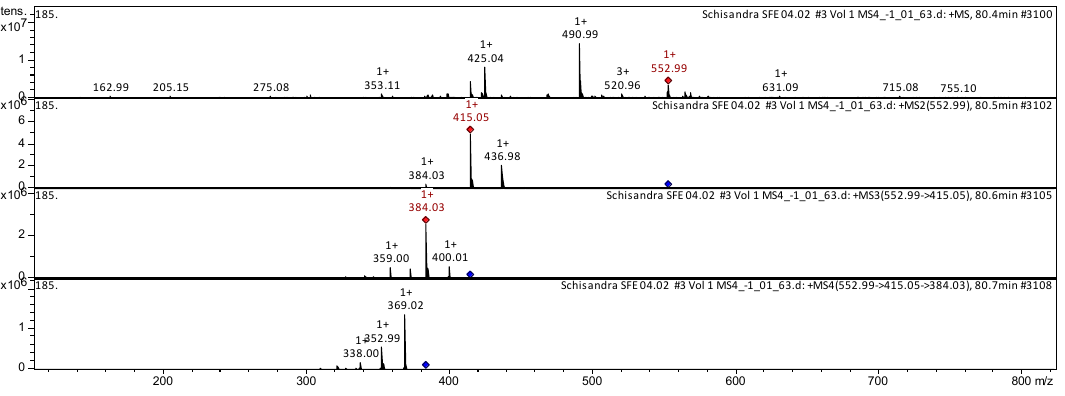
Figure 5 . CID spectrum of the benzoylgomisin Q from S. chinensis , m/z 522.99. Figure 5. CID spectrum of the benzoylgomisin Q from S. chinensis , m / z